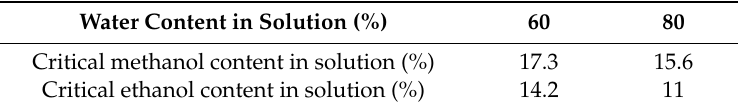
Table 2. Critical fuels contents (ratio of alcohol mass to water mass) in solution for the spontaneous flame